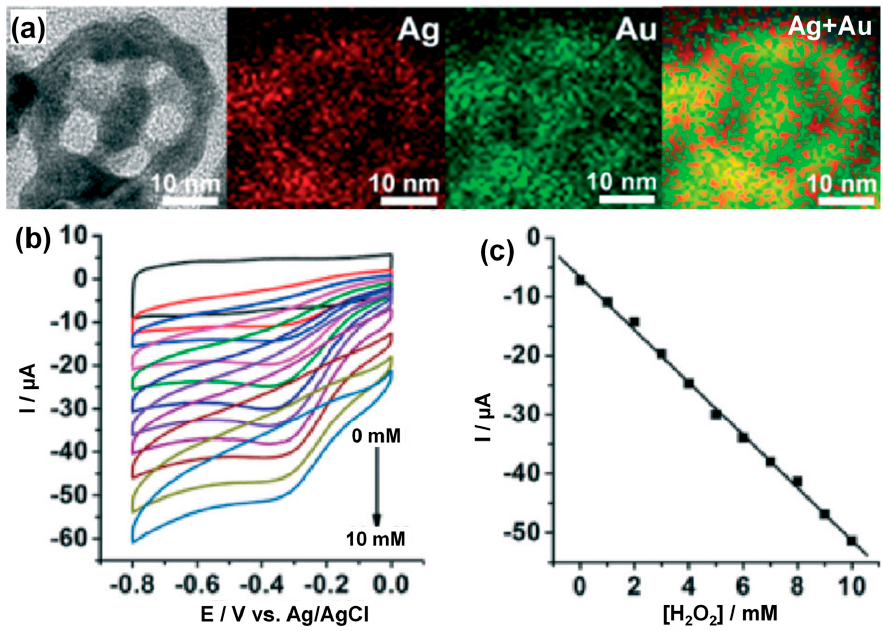
Figure 11. ( a ) EDS elemental mapping of the as ‐ synthesized quasi ‐ spherical Au nanocages; ( b )